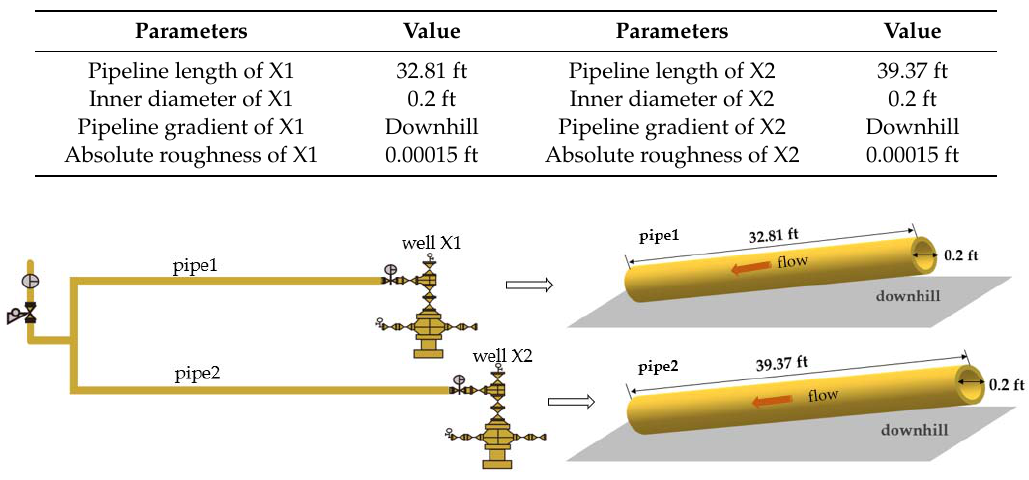
Figure 9. Schematic of an MWMS and the pipes.